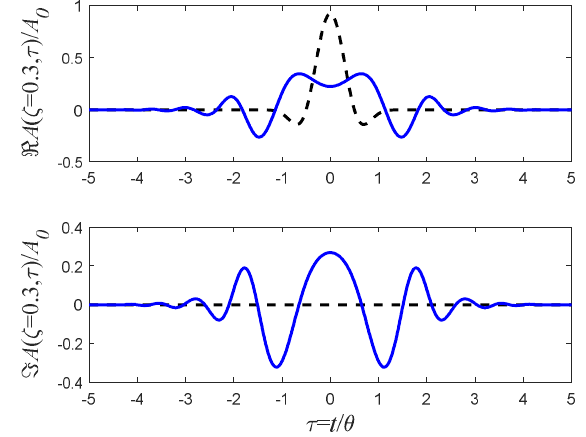
Figure 20. Same as Figure 12, but for Equation (75) with the transition width ∆ = 0.4 θ